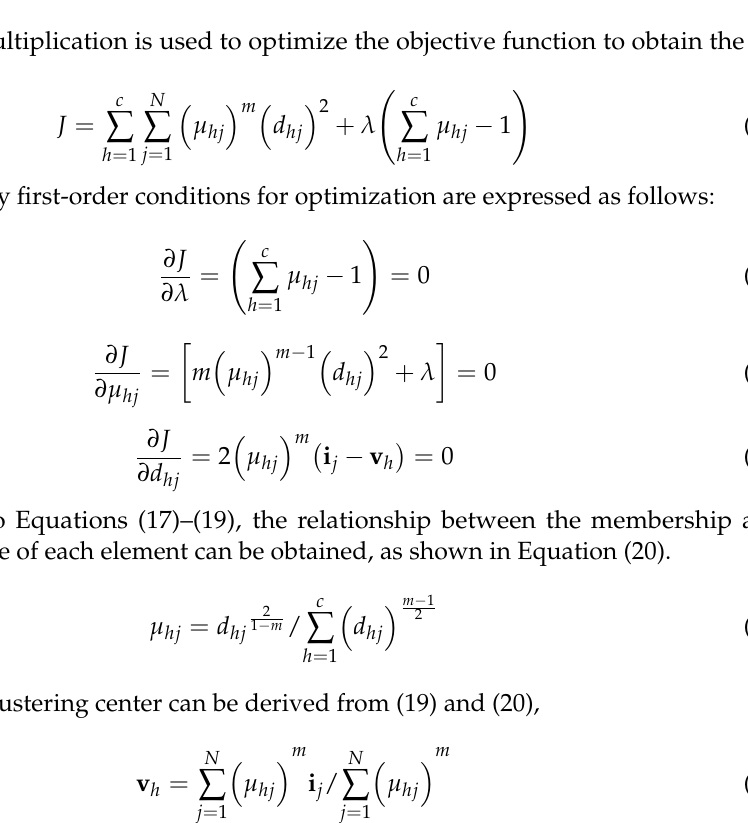
Figure 6. Original operating database of the converter valve cooling system.